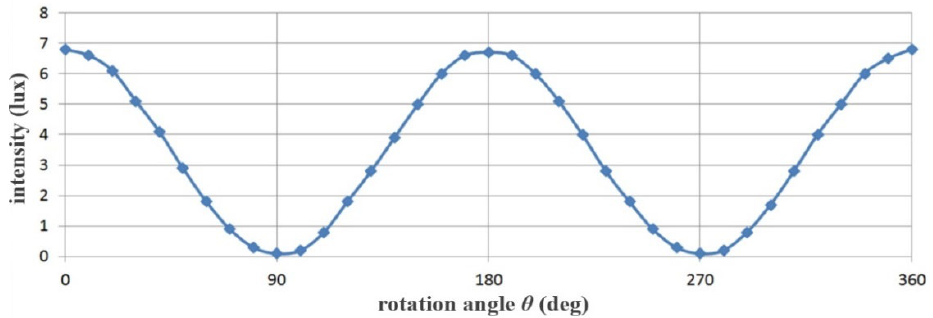
Figure 11. Variation of the specular reflection intensity according to the rotation axis of the filter.